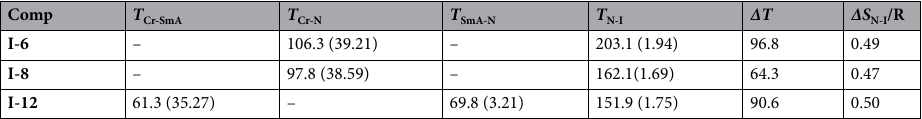
Table 1. Mesophase transition temperatures, o C (enthalpy of transition), mesomorphic range (ΔT, o C), and the normalized entropy of transition, ΔS/R, for present series In . Cr–N = solid to the nematic mesophase transition. Cr-SmA = solid to the smectic A mesophase transition. SmA-N = smectic A to the nematic mesophase transition. N-I = nematic to the isotropic liquid mesophase transition. ΔH = enthalpy of transition, kJ/mole; ΔS/R= normalized entropy of transition, unitless (due to the entropy change ΔS is divided by R= gas constant).